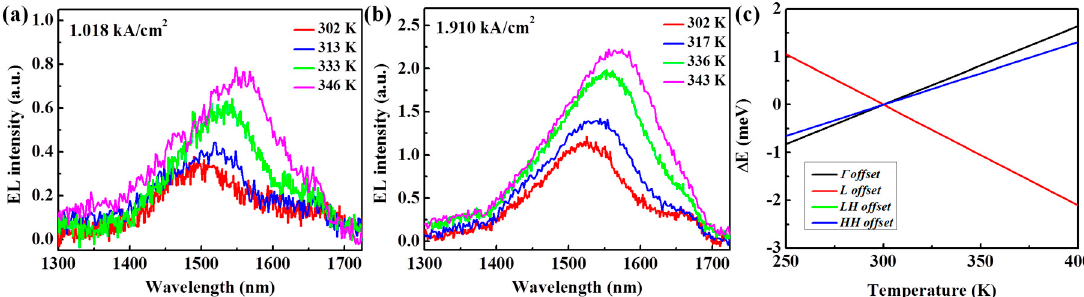
Figure 6. EL spectra measured at different environmental temperatures under constant injection current densities of ( a ) 1.018 kA/cm 2 and ( b ) 1.910 kA/cm 2 ; ( c ) Energy variations of band offsets between the Si 0.13 Ge 0.87 /Ge interface and the environmental temperature (250–400 K). The variations of the band offsets for the LH valance band and the Γ valley are almost identical.